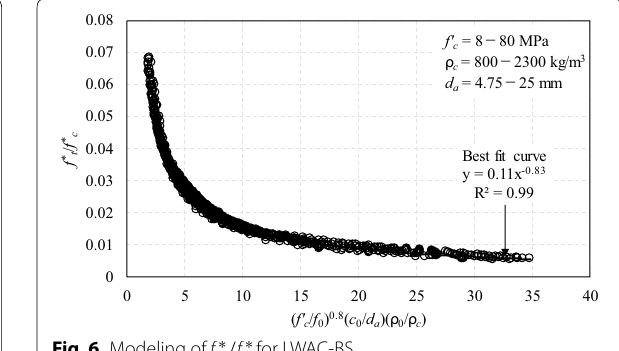
Fig. 6 Modeling of f ∗ t / f ∗ c for